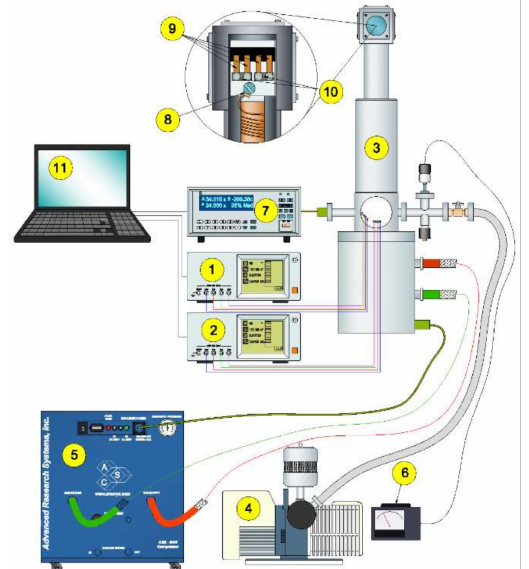
Figure 1. Test stand for determining electrical parameters [23]: 1 and 2—HIOKI 3532 LCR